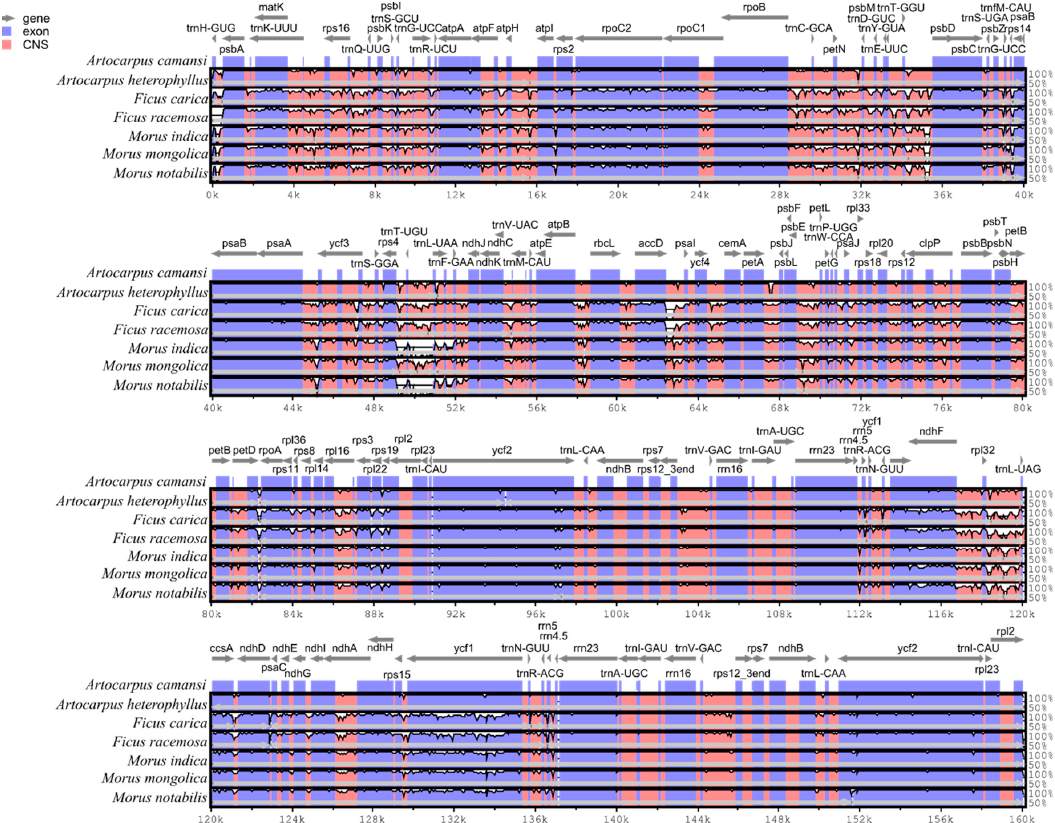
Figure 6. The alignment of the plastid genomes of seven species of the family Moraceae, with A. camansi as a reference. The vertical scale indicates the percentage of identity, which ranges from 50% to 100%. The coding regions are shown in purple, and the non-coding regions in red. The gray arrows above the alignment indicate the orientation of the genes.